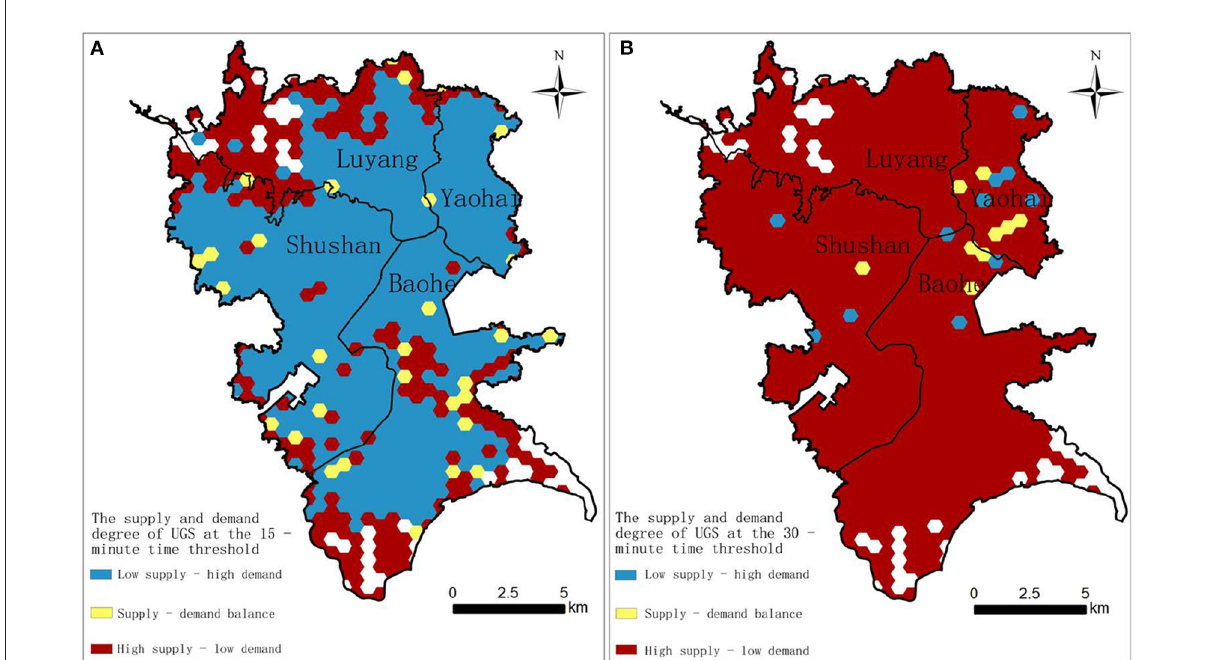
FIGURE7 Deviation between supply and demand of UGS at different time thresholds. (A) At the 15-min time threshold; (B) At the 30-min time